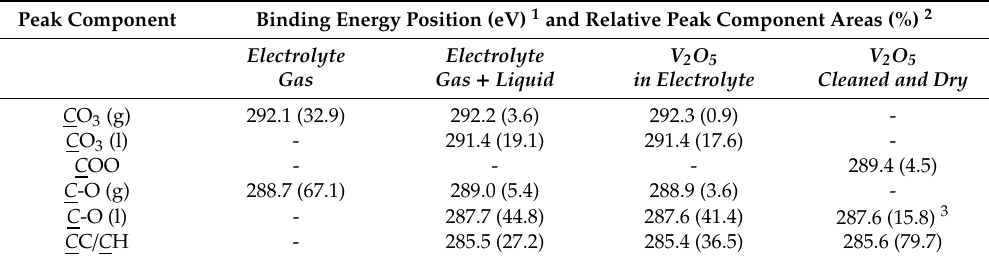
Table 1. Peak fit results of C 1s core-level spectra from LP30 electrolyte as shown in Figure 2. Peak Component